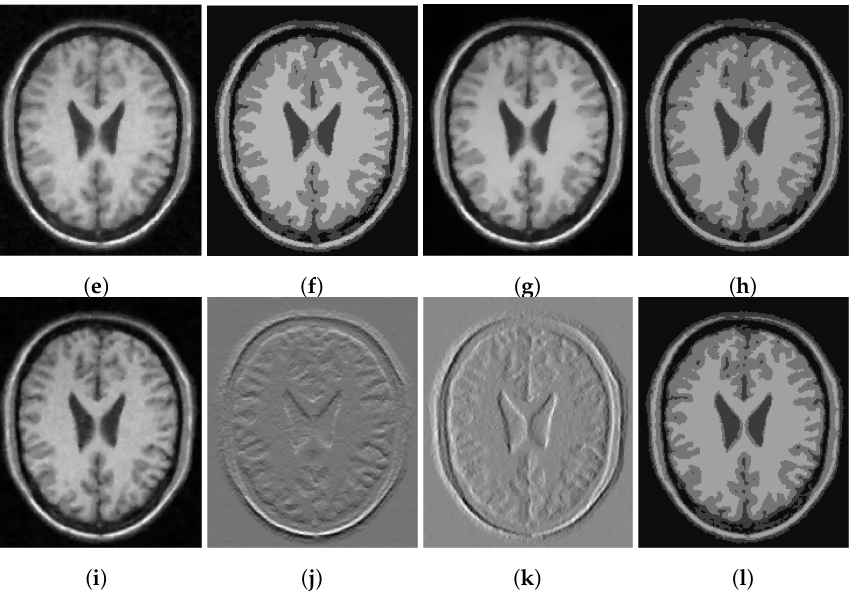
Figure 4. MRI segmentation: ( a ) Clean image. ( b ) Noisy image used as input to the models. ( c ) Output of CCZ. ( d ) CCZ after thresholding. ( e ) Output of CNC. ( f ) CNC after thresholding. ( g ) Output of T-ROF. ( h ) T-ROF after thresholding. ( i ) Output g of our model. ( j ) Output G x of our model. ( k ) Output G y of our model. ( l ) Ours after thresholding.